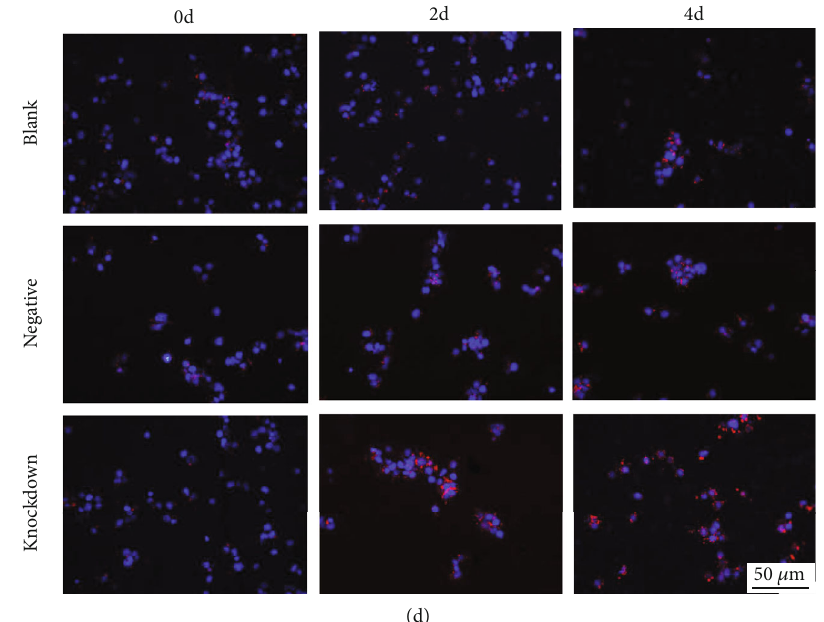
Figure 3: Downregulation of lncRNA STAT4-AS1 promoted the di ff erentiation of TH17 cells. (a) The proportion of TH17 cells on day 2 and day 4 of induced di ff erentiation. Flow cytometry fi gures (left) and statistical analysis (right) of TH17 cells. (b) The mRNA level of STAT4-AS1, STAT4, IL-17A, ROR γ t, IL-17F, and IL-21 on days 2 and 4 of induction. (c) The levels of IL-17A in cell supernatant were detected using ELISA. (d) Immuno fl uorescence was used to determine the protein expression of ROR γ t. Three independent experiments were performed, and data are presented as the mean ± SD . ∗ p < 0 : 05 , ∗∗ p < 0 : 01 , and ∗∗∗ p < 0 : 001